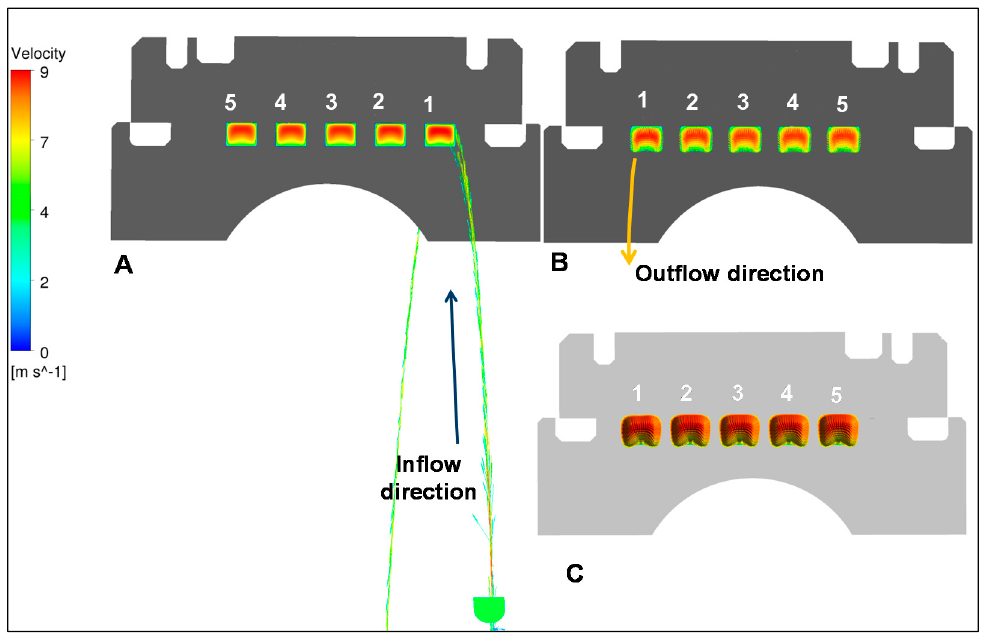
Figure 20. The five loops of the coil duct around the outer ring are shown. In cut A the typical kidney like isotachs are shown. The flow is moving into the plane whereas in B the flow is coming out of the plane from the other side. The flow structure in arrows form is shown in C. This is in good agreement to the flow pattern by Adler [30].